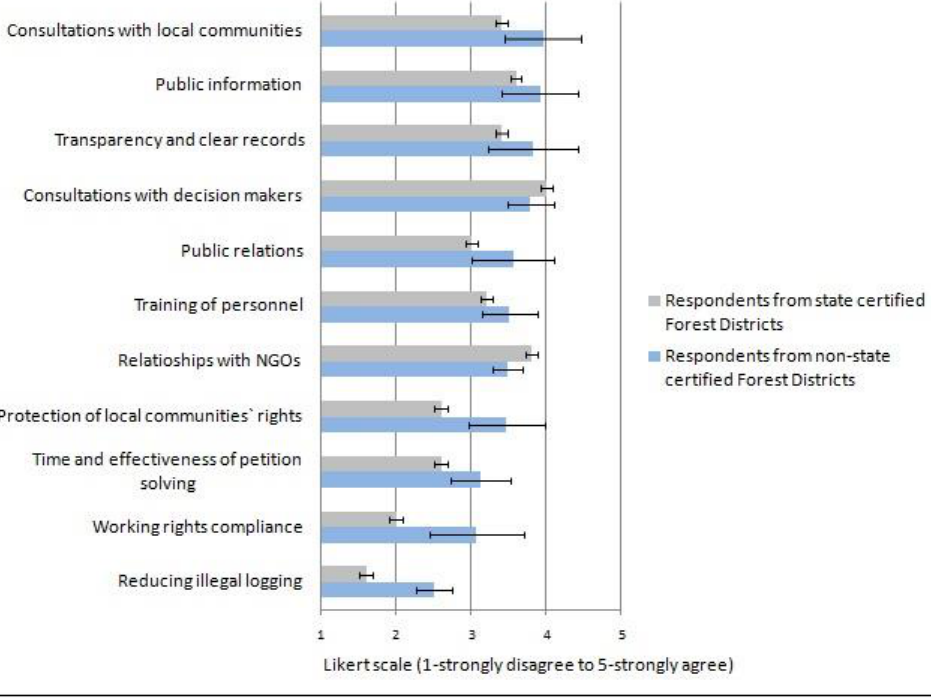
Figure 6. FDs FSC responsible persons’ perception over the changes brought to social aspects by FSC forest management certification (Likert scale question: Indicate, on a scale from 1 to 5 the improvements determined by FSC certification on the analyzed aspects (in Supplementary)).